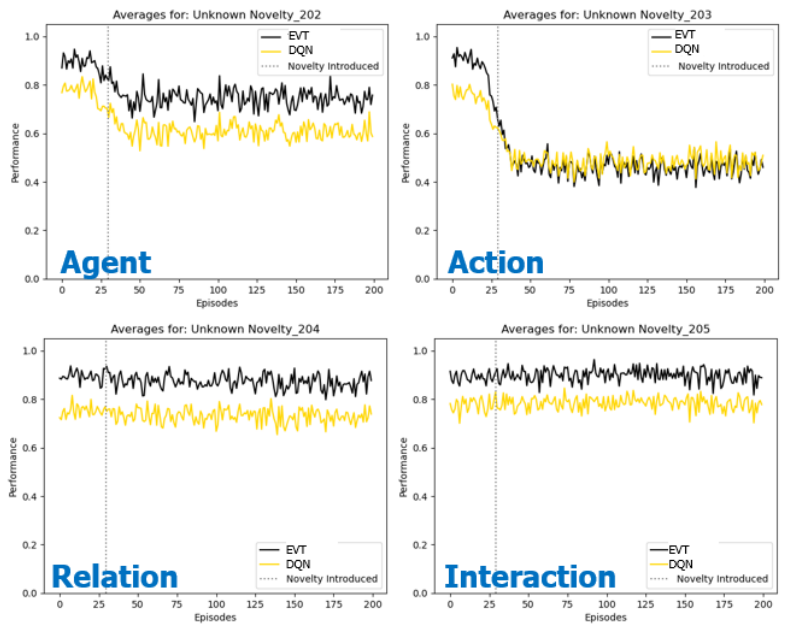
Figure 4. Performance plots showing average performance for different subtypes of novelty. The plots show a vertical line at the expected value of where novelty was introduced. Still, because trials have actual random locations, there is a spread of where novelty was introduced, producing the quasi-linear impact region. The plots show the control agent in black and the baseline DQN agent in yellow. Visually, both relation and interaction novelties were nuisance novelties to both agents as their performance does not change after novelty is introduced. In three of the four types of novelties, the lookahead collision avoiding control performed better than the baseline DQN agent. However, one can observe that in action novelties, the two agents’ performance is similar after novelty is introduced, likely because neither can handle agents that target the